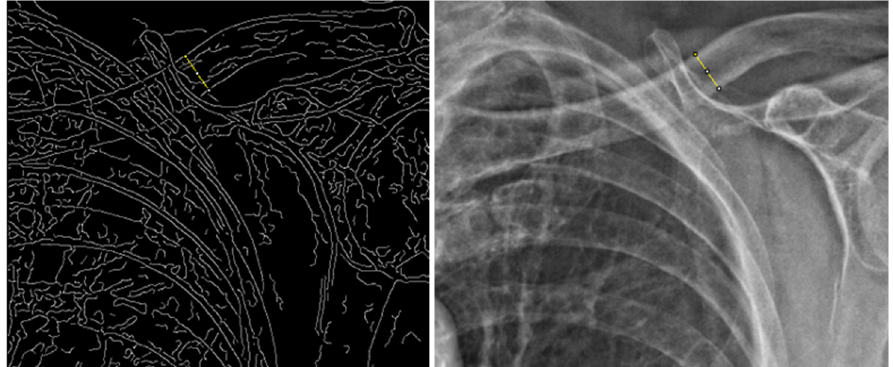
Figure 2. Graphical analysis conducted with Fiji. The region of interest (yellow line) was determined using Canny edge detection, while the pixels were analyzed under enhanced local contrast.